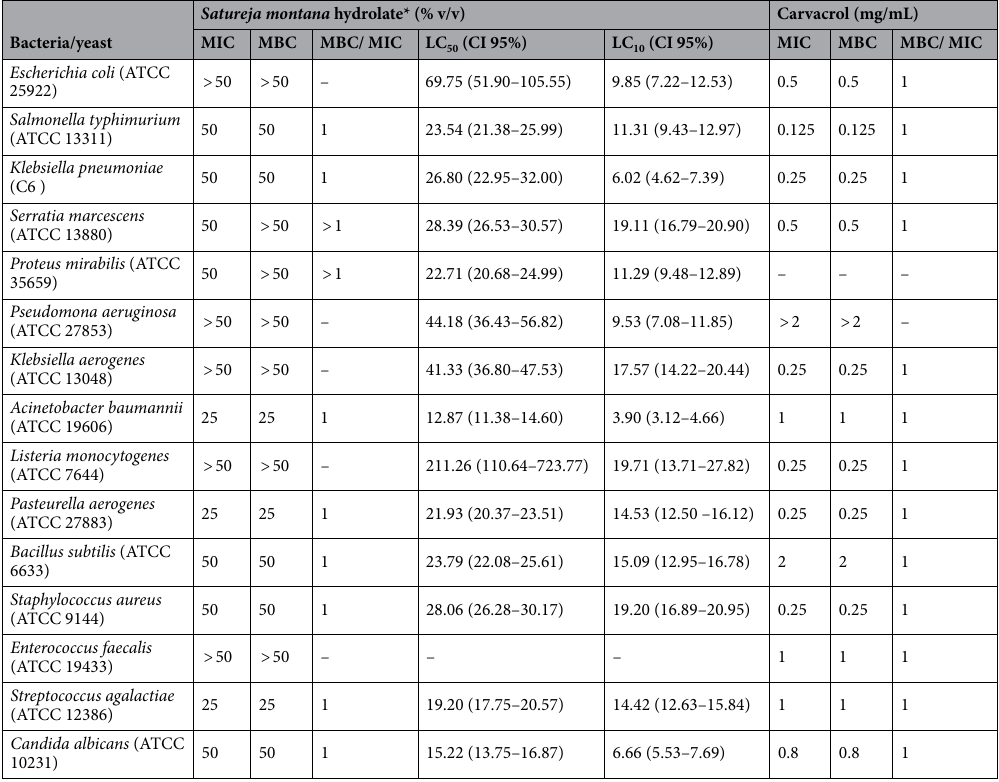
Table 1. Antimicrobial activity of Satureja montana hydrolate and carvacrol against all tested strains. CI (confidence interval), MIC (minimum inhibitory concentration), MBC (minimum bactericidal concentration). –: test not done due to incompatibility with solvents or insufficient data. * Main components concentration: Thymol 9.94 µg/mL, Carvacrol 243.20